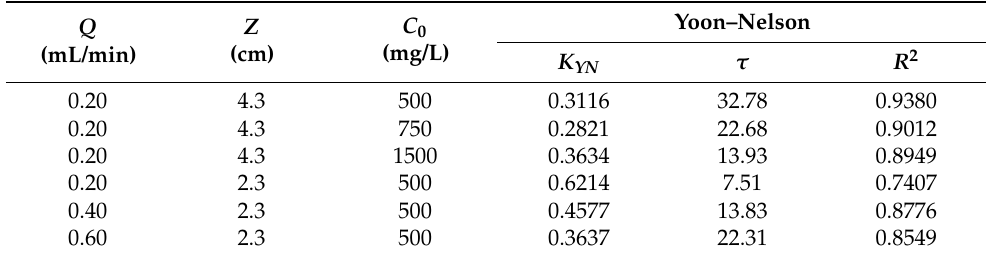
Table 3. Kinetic model constants of Yoon–Nelson model on the adsorptive removal of Pb(II) from aqueous solution using CCB.